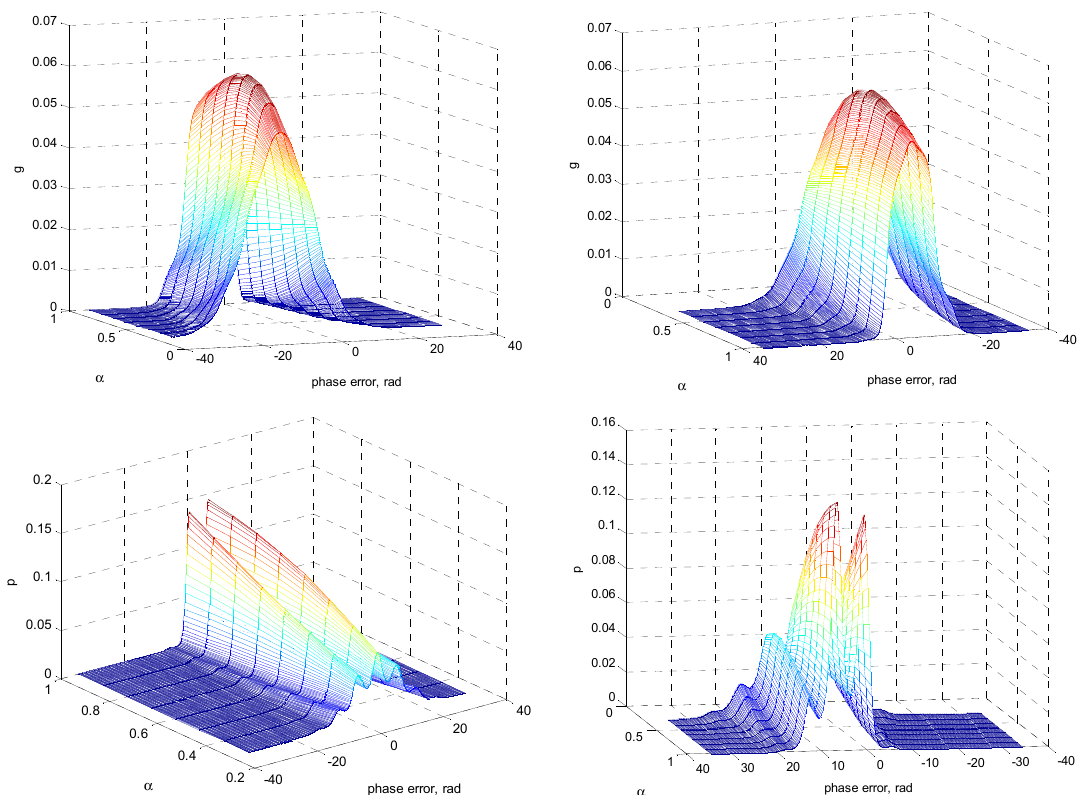
Figure 13. Three-dimensional plots for nonmodulo-2 π g and p , respectively, at τ = 10 for various SNR values: front view ( left ) and back view ( right ; γ = sin ( π /4 ) ).